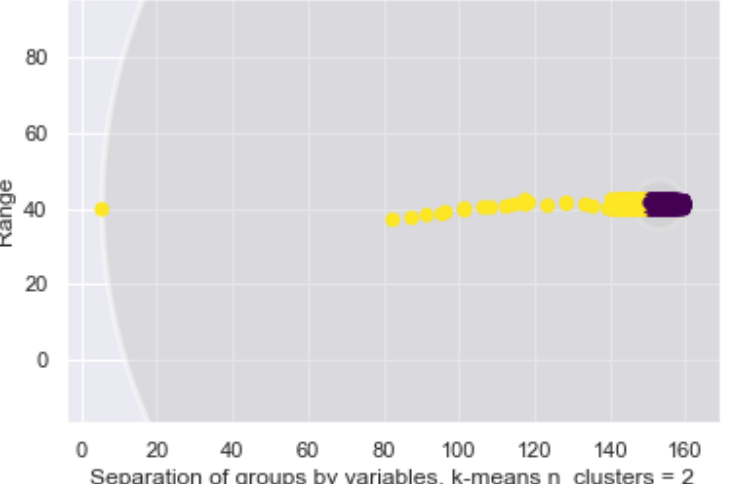
Figure 17. The K-Means between temperature and heartbeat with 2